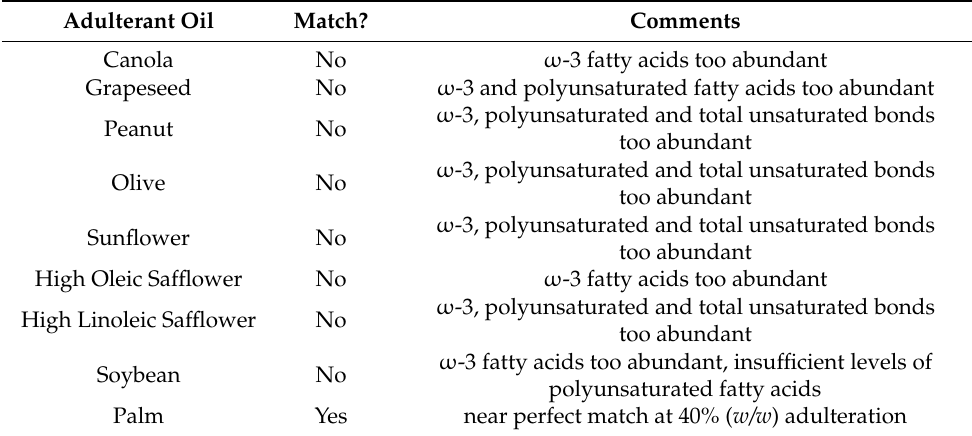
Table 2. Adulterant identification trial results.